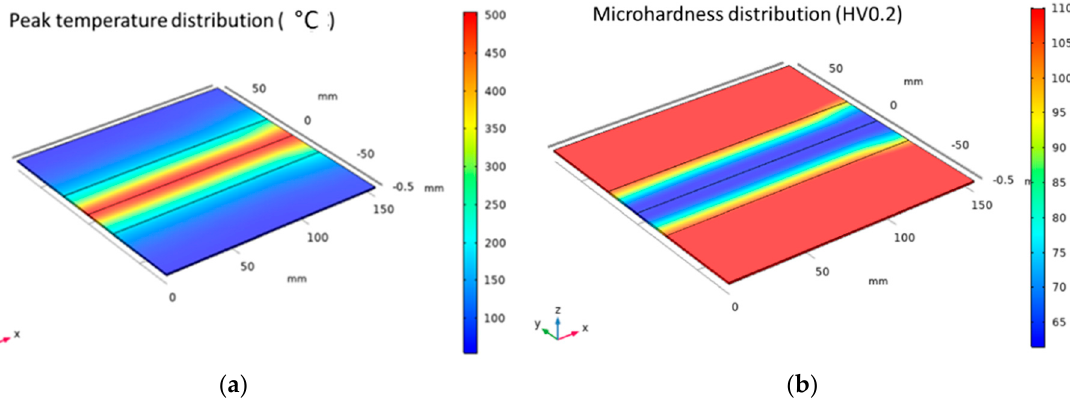
Figure 32. ( a ). Blank peak temperatures distribution in the laser treatment carried out at the peak temperature of 500 °C and treatment speed of 5 mm/s; ( b ) Hardness distribution in the blank in APS state in the treatment carried out at the peak temperature of 500 °C and treatment speed of 5 mm/s.